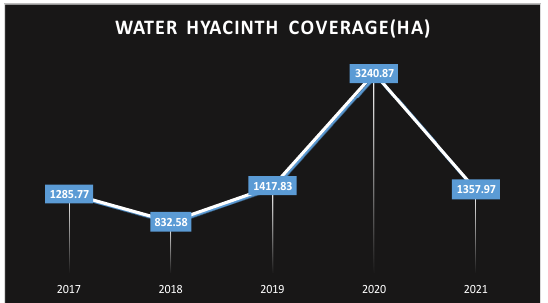
Figure 7: Shows the area change of water hyacinth over the years When the lakes suspended sediments, turbidity levels and presence of nitrogen content are mapped; there is a close agreement of presence of undissolved pollutants depicting a low water quality of Lake Victoria waters.